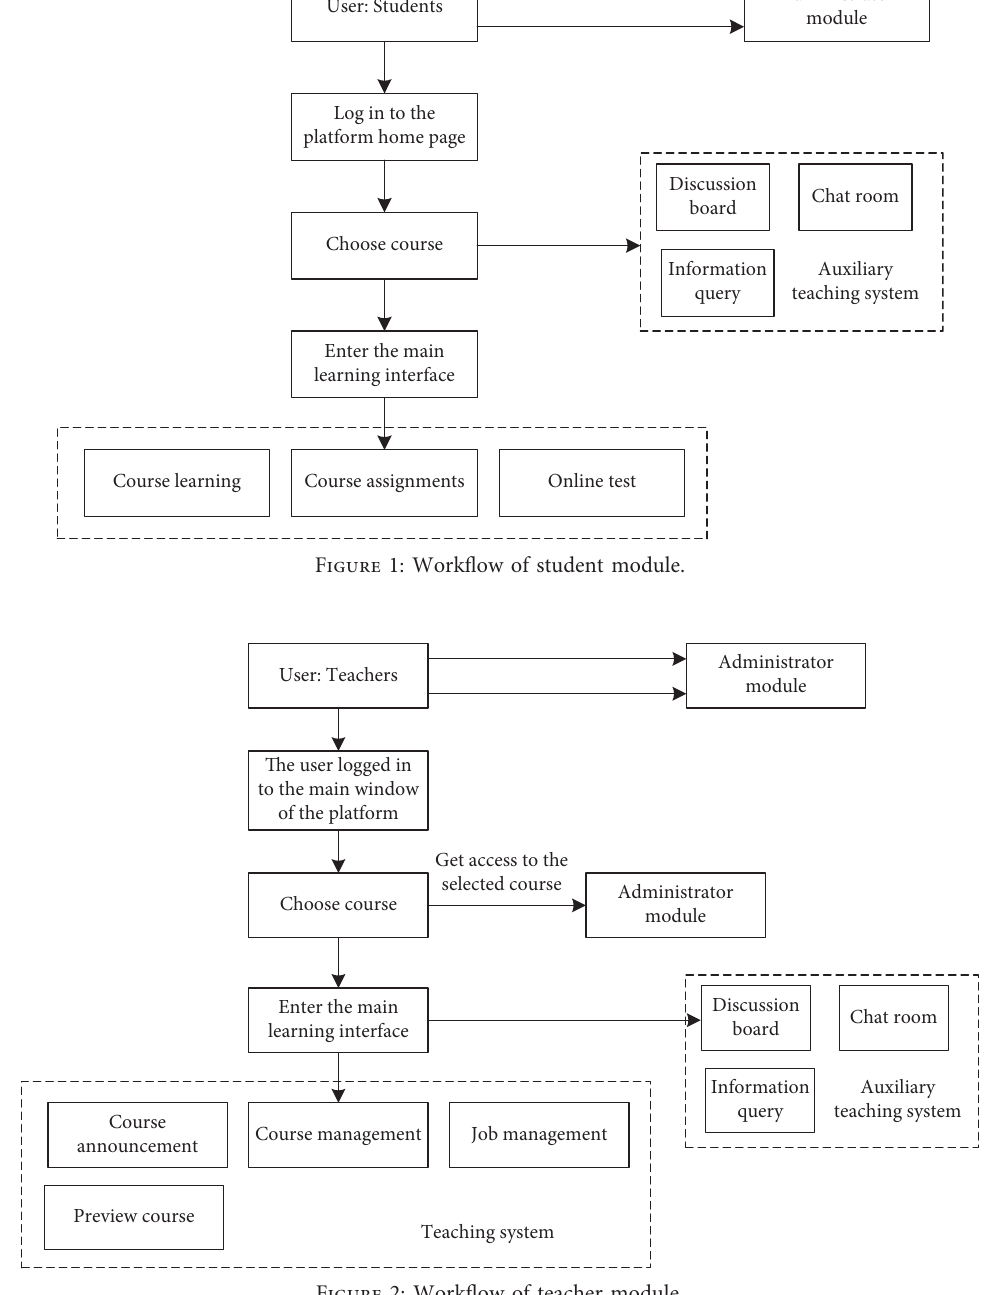
Figure 2: Workflow of teacher